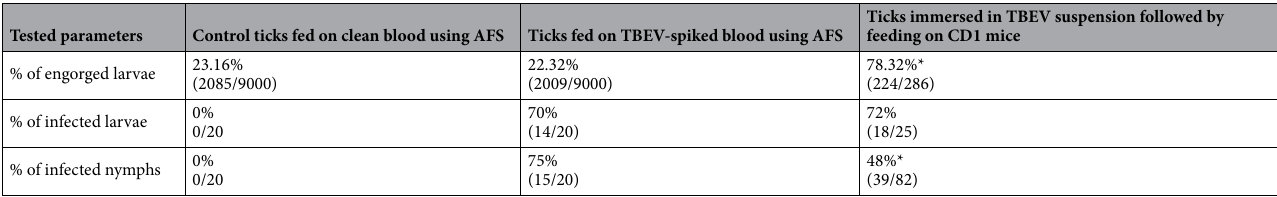
Table 1. Engorgement rates of larvae and TBEV infection in engorged larvae and nymphs infected at larval stage after artificial feeding (AFS) or immersion techniques (khi-2 test, alpha = 5%, *: p value <